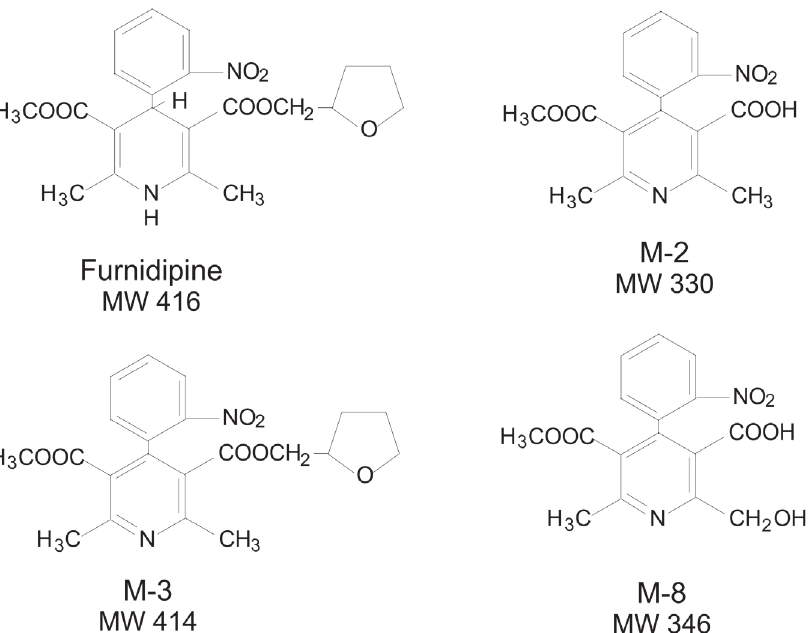
Figure 1. Structure and molecular weight of the three tested major metabolites of furnidipine, M-2, M-3 and M-8.